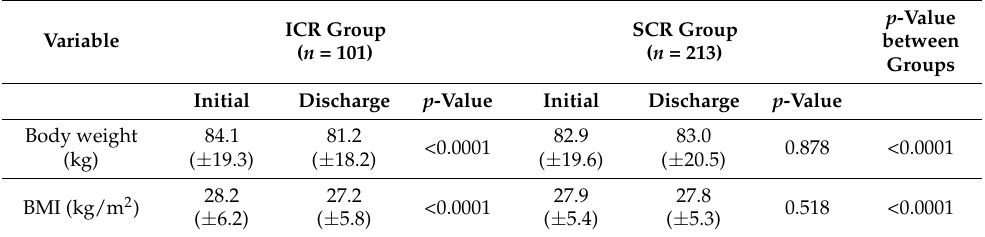
Table 2. Changes in various parameters between the entry and discharge from cardiac rehabilitation program within and between the patient groups undergoing intensive cardiac rehabilitation (ICR group) and standard cardiac rehabilitation (SCR